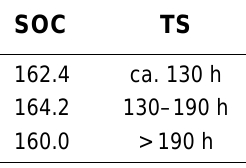
SOC, Dependent on Number of